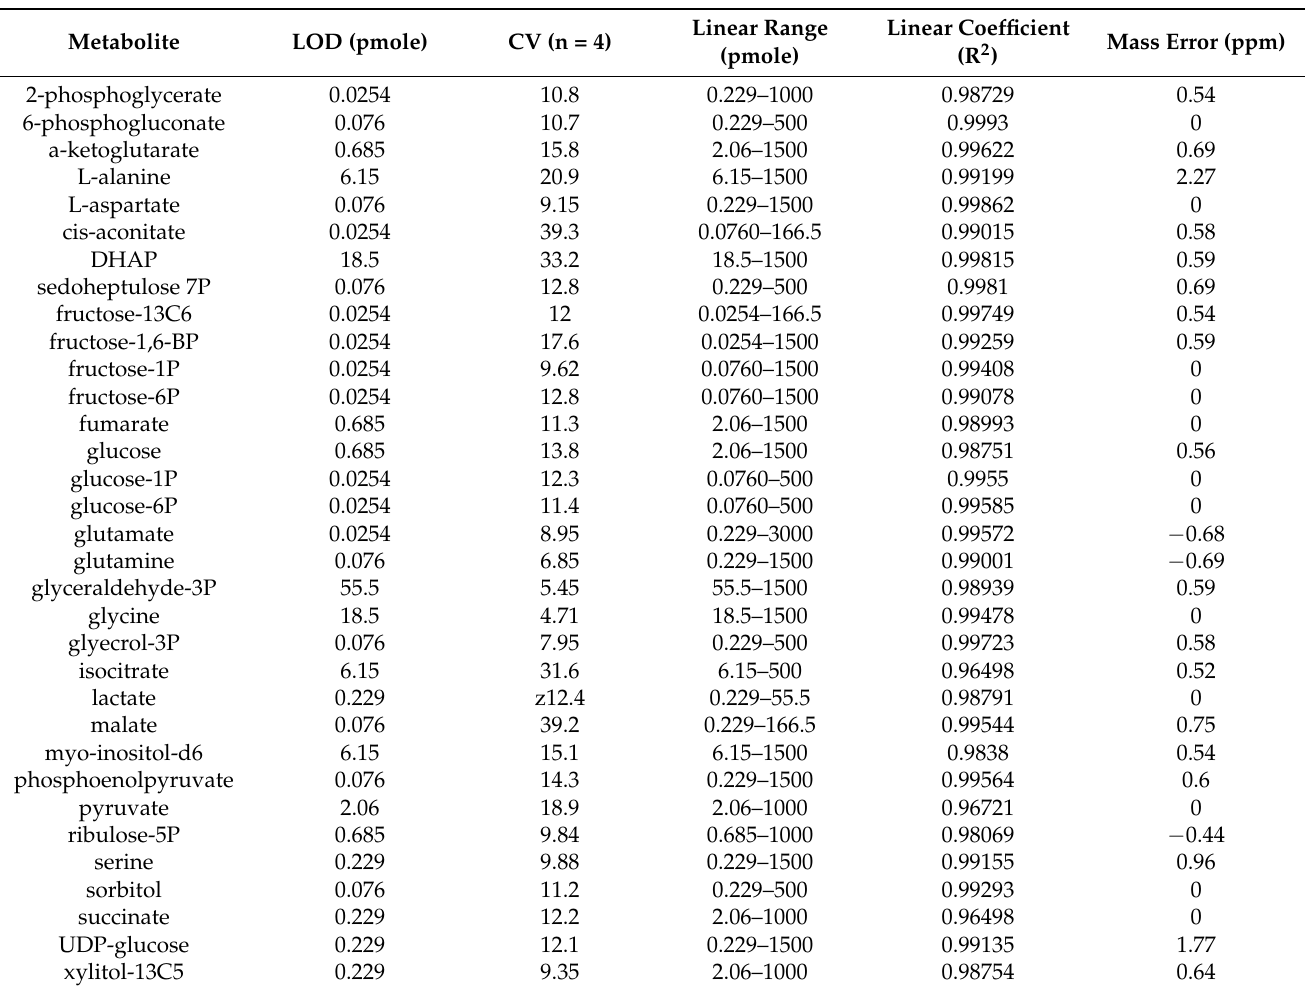
Table 1. Method sensitivity and